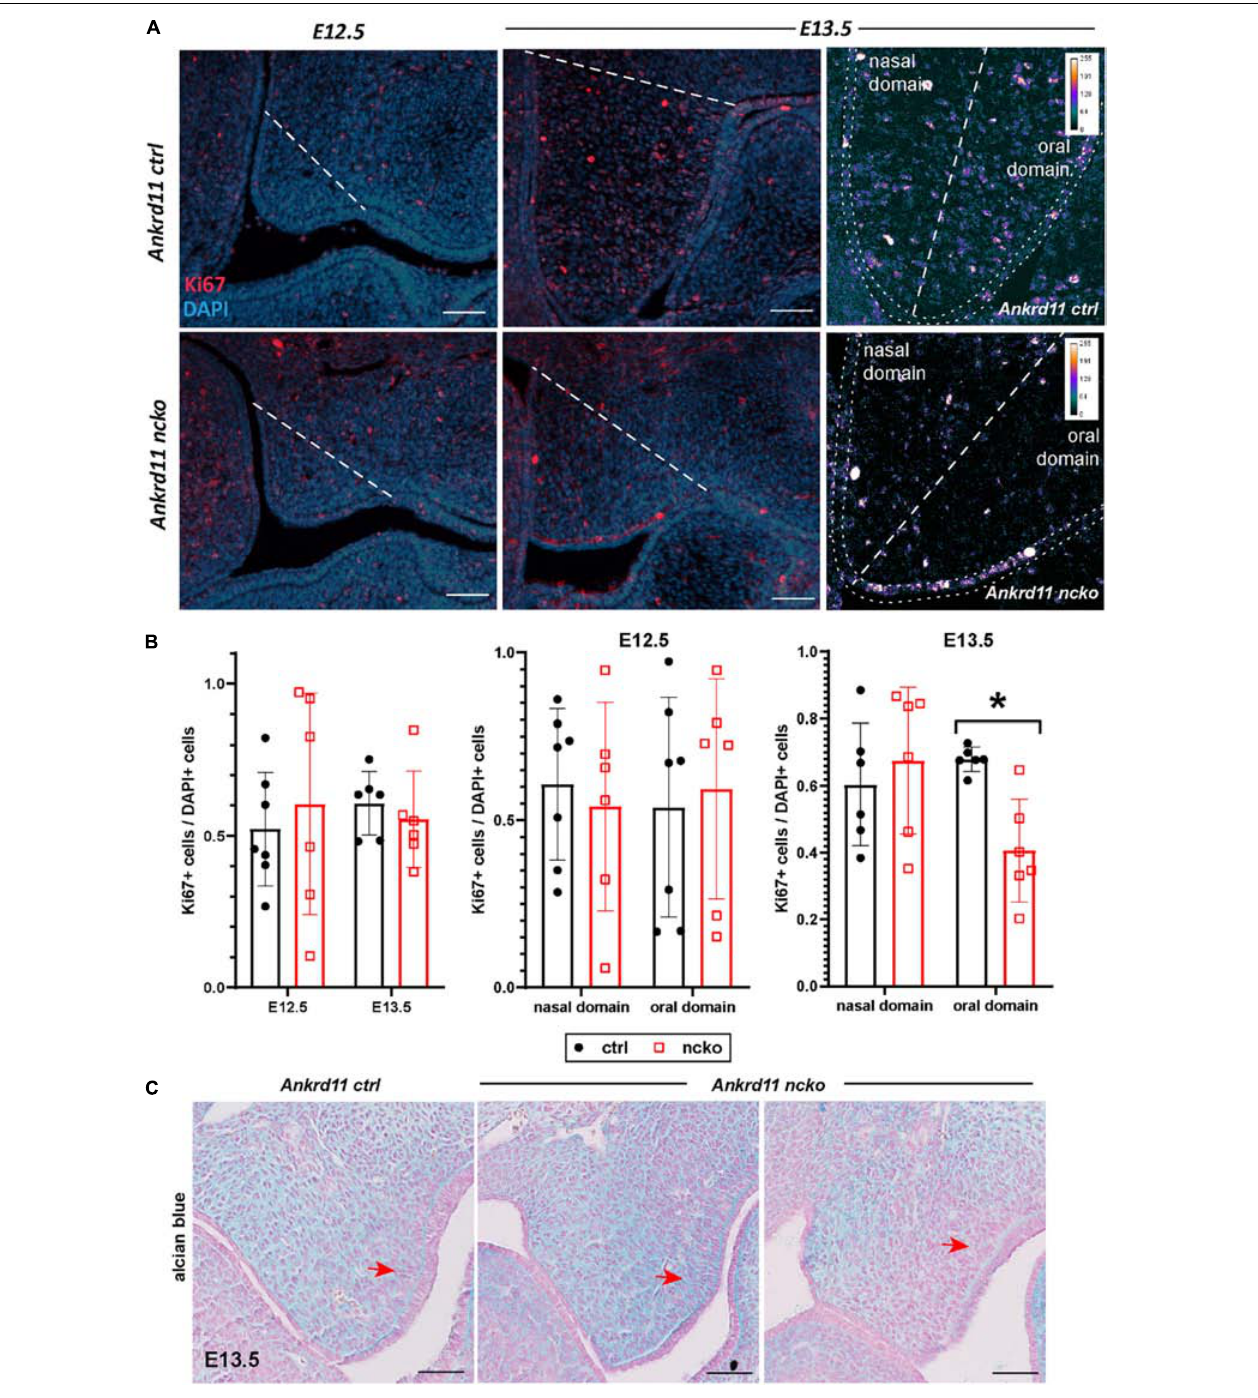
FIGURE 5 | Palatal shelf proliferation is locally affected in Ankrd11 ncko embryos. (A) Representative images of palatal shelves at each age and timepoint immunostained for Ki67 (red). DAPI-labeled nuclei are in blue. White dotted line delineates region counted for quantification shown in (B) . White scale bars represent 50 µ m. Right panels: Magnification of E13.5 palatal shelf showing heatmap of Ki67 expression using ImageJ. White dotted line separates the nasal and oral domains of the palatal shelf. Scale bars represent 50 µ m. (B) Left panel: Quantification of Ki67-positive cells relative to DAPI-positive nuclei plotted for each genotype (Ankrd11 ctrl depicted in black and Ankrd11 ncko depicted in red at E12.5 and E13.5). Middle and right panel: Cell proliferation in nasal and oral domains respectively (independent two-sample T -test assuming unequal variances, minimum of six sections/genotype from minimum of five embryos per genotype, * p < 0.05, n = 6). (C) Alcian blue/nuclear fast red staining of E13.5 palatal shelves. Red arrow indicates mesenchymal cells lining epithelium on buccal side of shelf. n = 3/genotype, representative images shown. Scale bars represent 50 µ m.